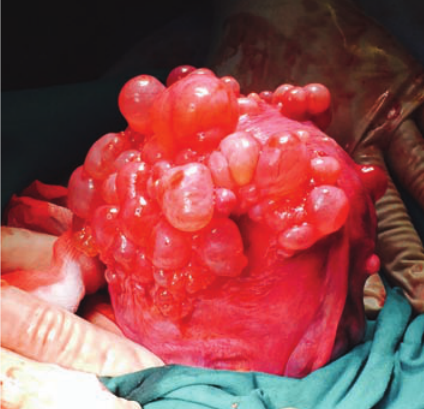
Figure 1: Macroscopic view of the cystic endosalpingiosis lesions after the cesarean delivery. The uterine fundus and part of the body are completely seeded with multitude of cyst-like structures resembling hydatids of Morgagni but with a harder structure due to the muscular component.